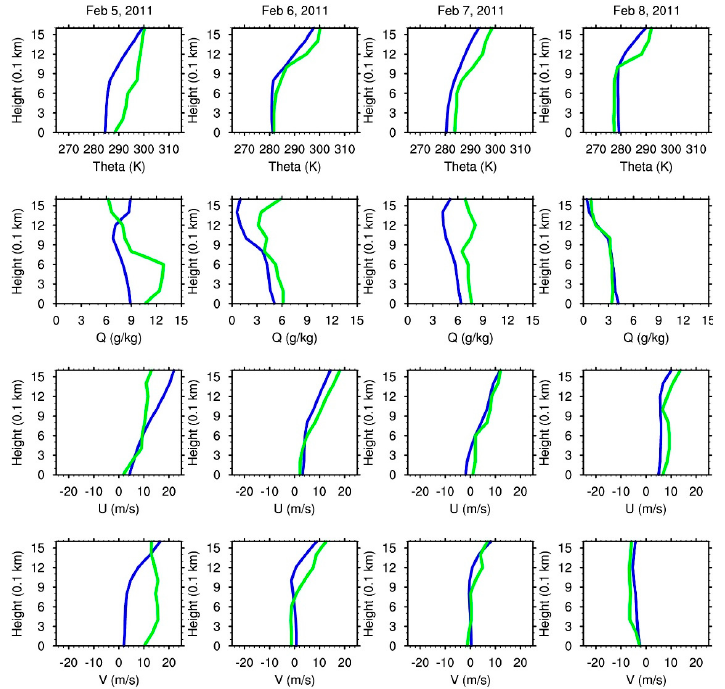
Figure 5. Vertical profiles of potential temperature (K) ( top ), specific humidity (g/kg) ( second row ), westerly and southerly wind components (m/s) ( third and fourth rows ) at Fort Stewart simulated with WRF (blue) and Jacksonville, FL observed from radiosonde (green). The columns from left to right are 5–8 February 2011 at noon local time.